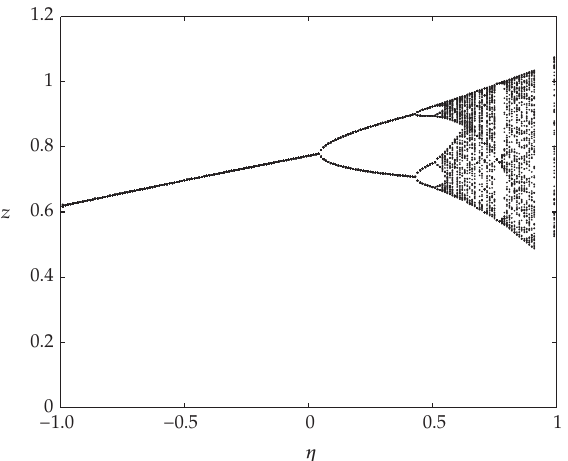
Figure 4: The output of the controlled system with r (cid:7) 0 . 40, α (cid:7) 0 . 63, and η (cid:7) (cid:3) − 1 , 1 (cid:4) .